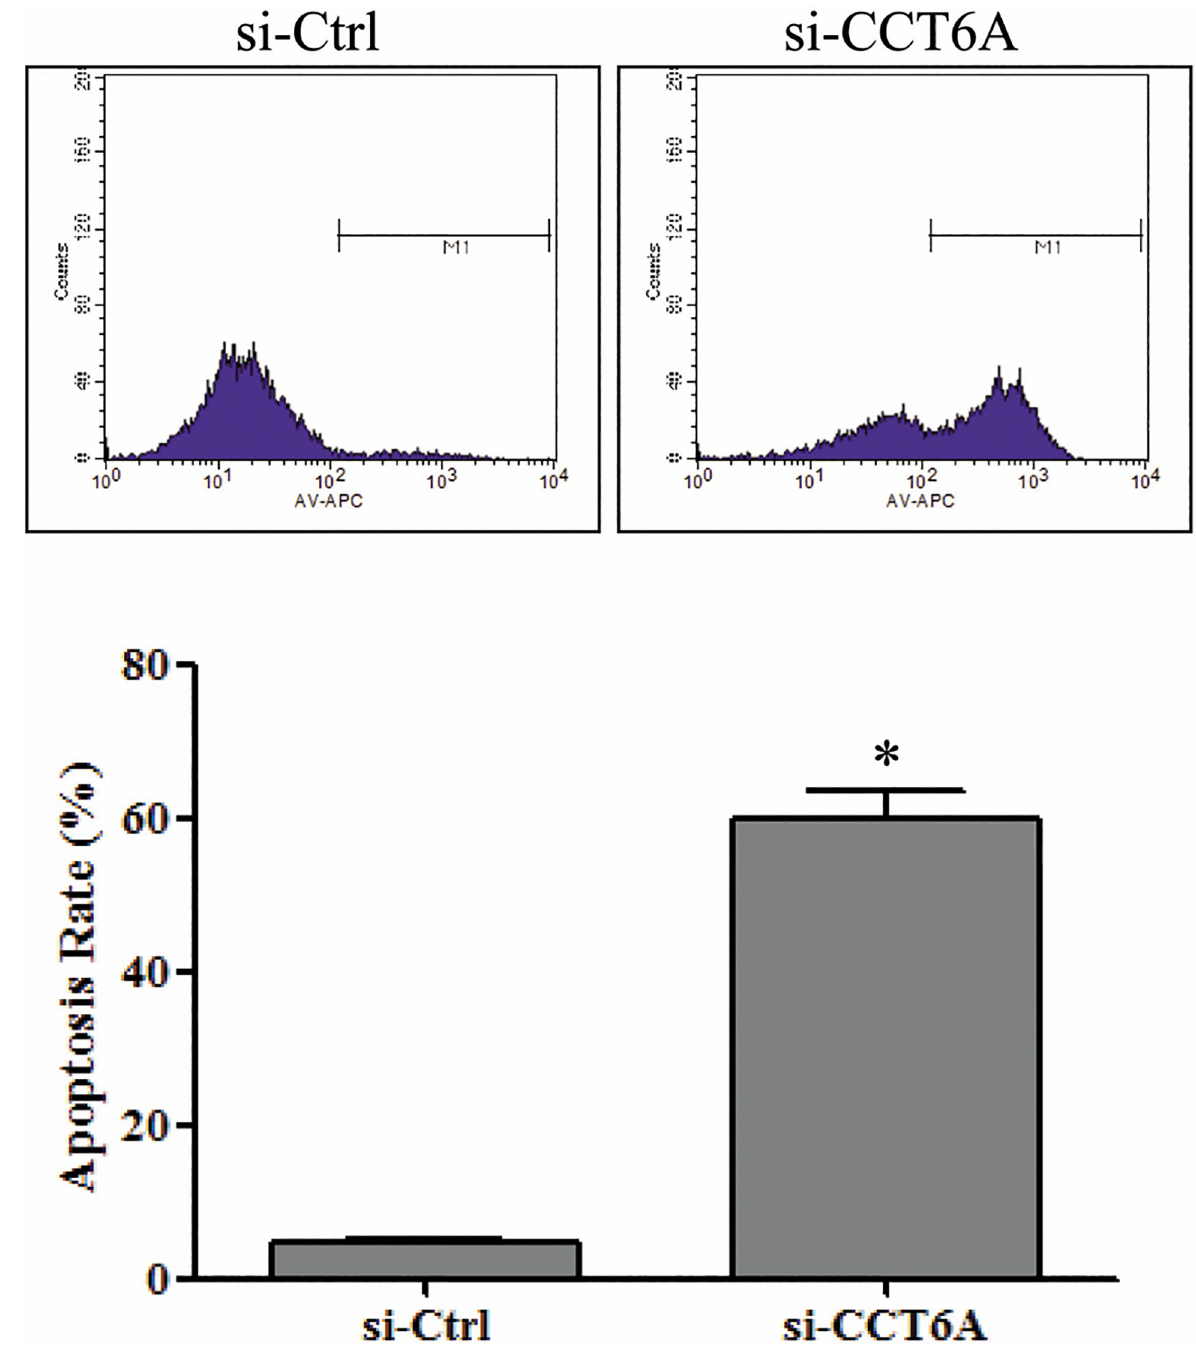
Fig 5. The effect of CCT6A on U-2 osteosarcoma cell apoptosis. After transfection with si-CCT6A-3 or control siRNA (si-Ctrl) for 72 h, U-2 osteosarcoma cells were stained with APC annexin V solution, and cell apoptosis was analyzed using flow cytometry. Data are presented as mean ( ± SD). n = 3. � p < 0.05 vs. si-Ctrl. APC, allophycocyanin; CCT6A, chaperonin-containing TCP1 subunit 6A; SD, standard deviation; siCT6A-3, CCT6A siRNA; si-Ctrl, control siRNA; siRNA, small interfering ribonucleic acid.